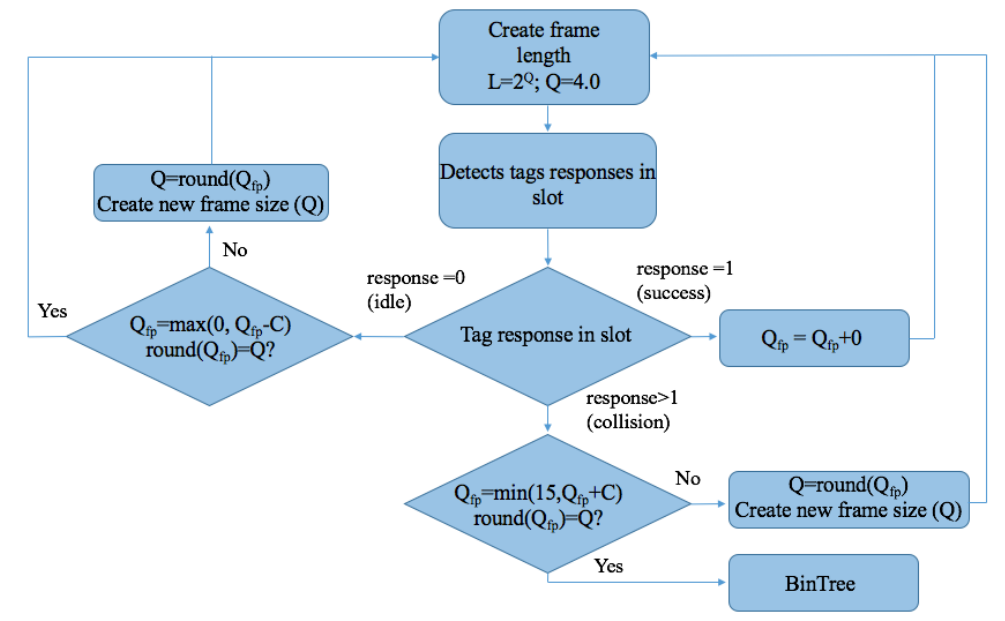
Figure 24. Flow chart of Adaptive